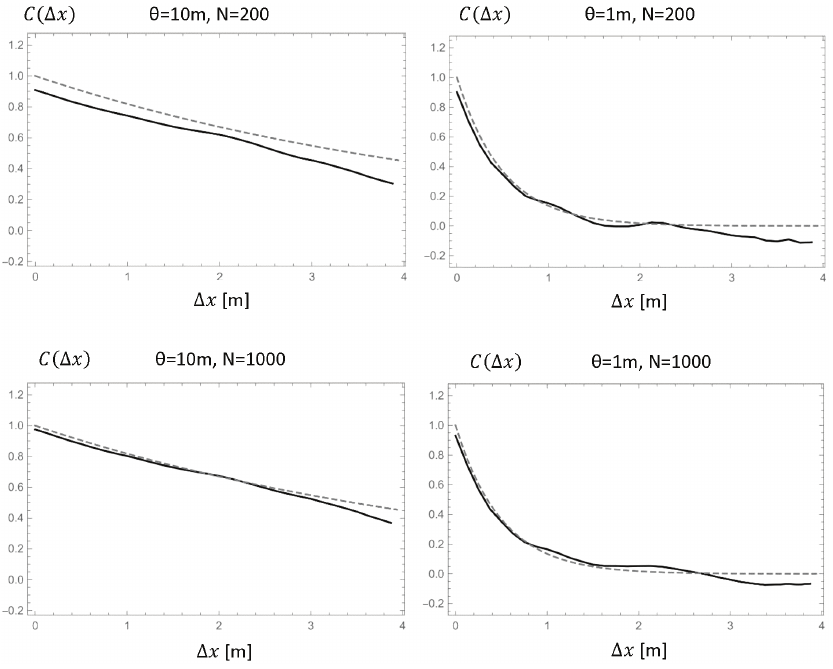
Fig. 2. Comparison of theoretical and estimated covariance functions (averaged over N realizations) for two different values of fluctuation scale θ and realization number N . N and θ specified above in respective